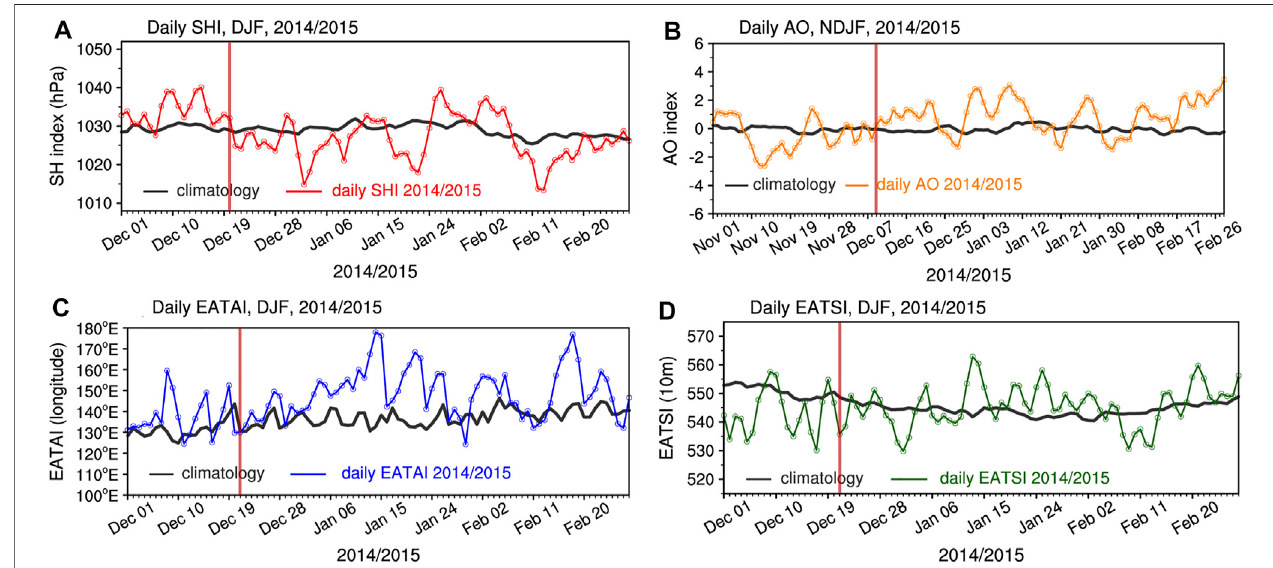
FIGURE 2 | Time series of daily indices: (A) intensity of the Siberian high; (B) AO; and (C) the location of the axis and (D) intensity of the EAT.